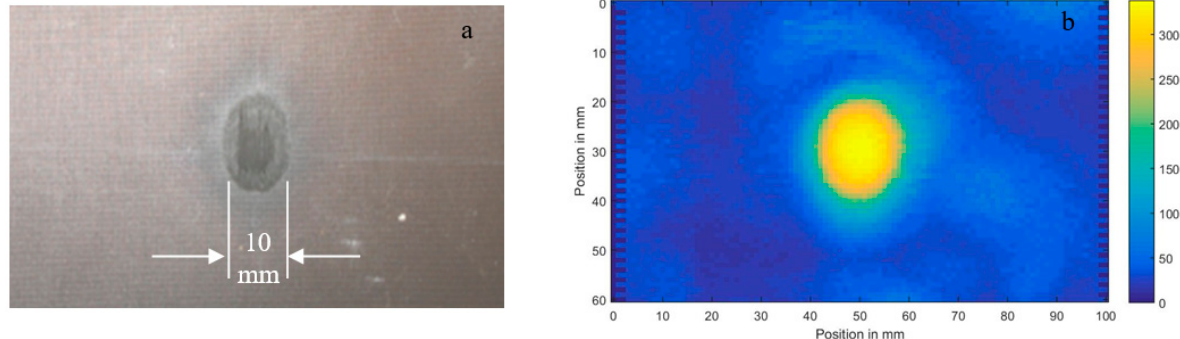
Figure 6. Heat-induced damage in CFRP ( a ) and its RACE image at LDR frequency 10600 Hz ( b ).